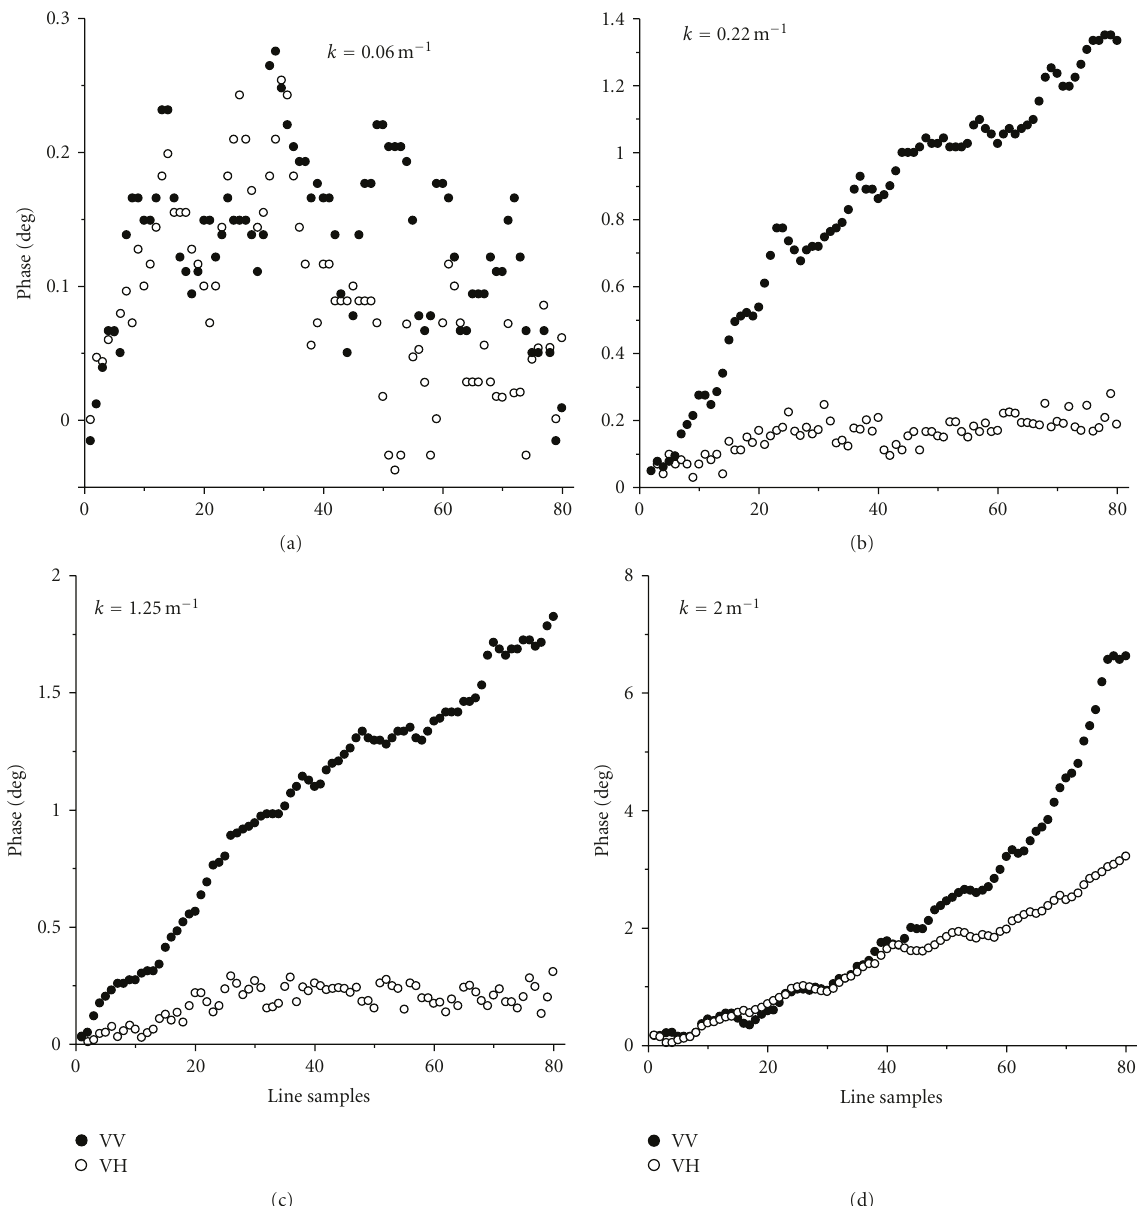
Figure 10: Linear phase profiles of a flat metallic target (z T = 1 . 56m) corresponding to VV (filled circles) and VH (open circles) schemes, for water of various turbidity levels. The AM laser beam ( f m = 39MHz) was linearly polarized perpendicularly to the reference plane (vertical linear